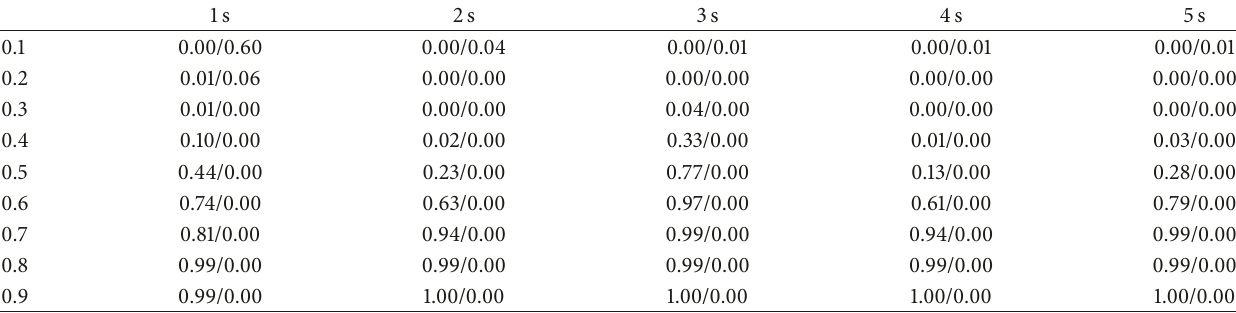
Table 4: FN and FP for the